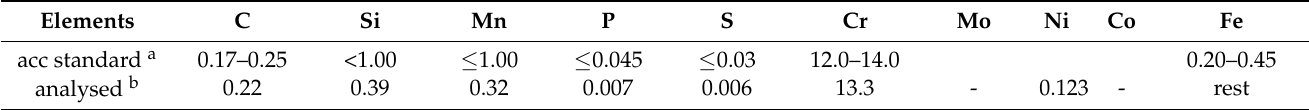
Table 2. Chemical composition of 1.4021 (X20Cr13, AISI 420A), in mass percent.